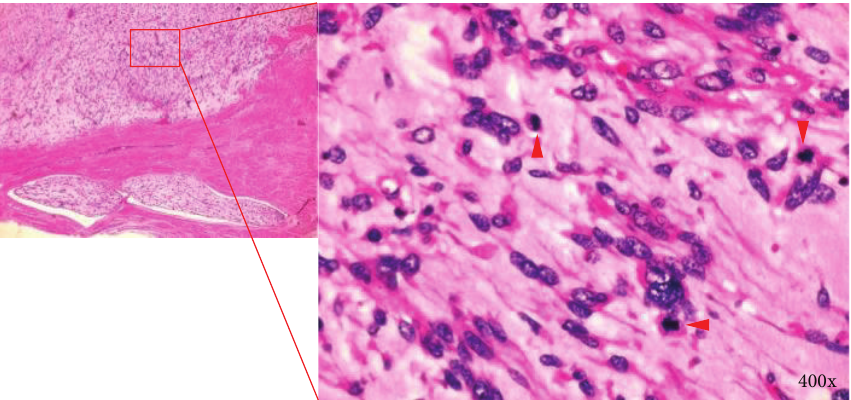
Figure 4: Infiltrating border of the tumor. Arrowheads indicate mitotic